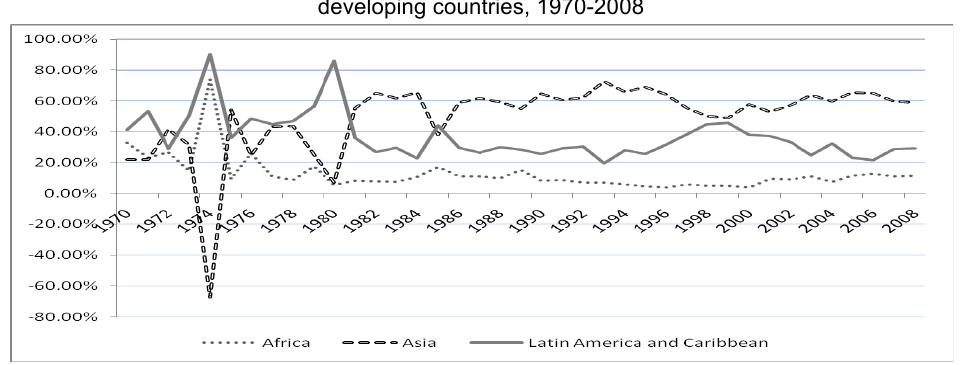
FDI inflows to developing regions, as percentage of total nominal inflows to developing countries,